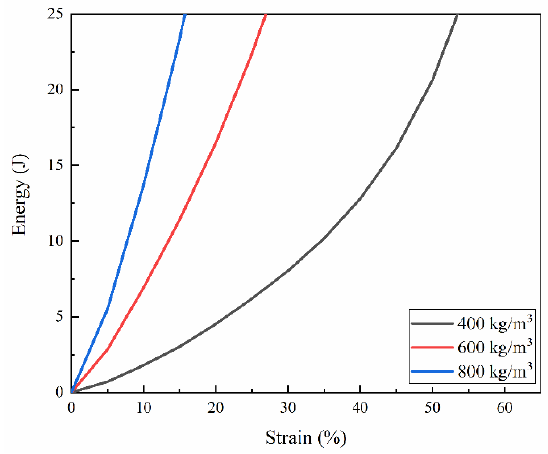
Figure 10. Energy–strain curves of PUMEs resulted from dynamic compression tests at 23 °C ± 2 °C.